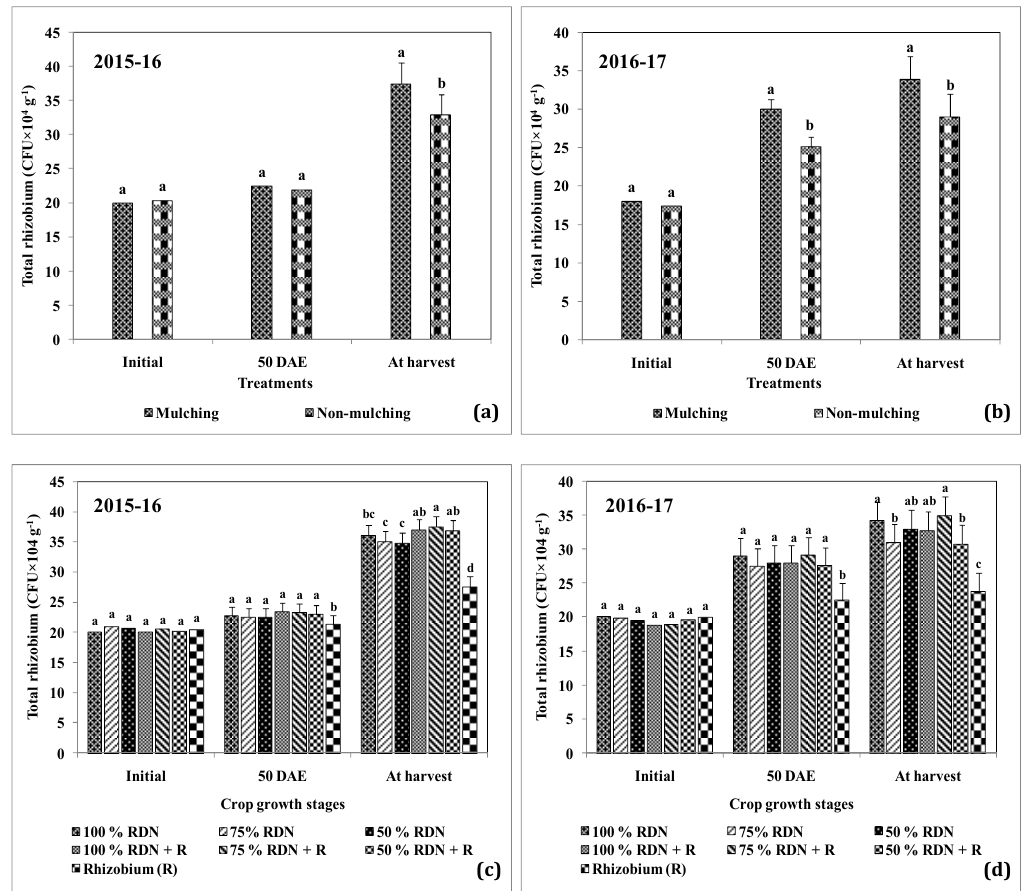
Figure 3. Effect of mulch ( a , b ) and nutrient dose ( c , d ) on soil Rh populations at different growth stages of peanut (data from 2015–2016 and 2016–2017 crop seasons respectively); DAE—days after emergence; within treatments, different letters indicate significant differences at p ≤ 0.05 (otherwise statistically at par); error bars represent the least significant difference value.